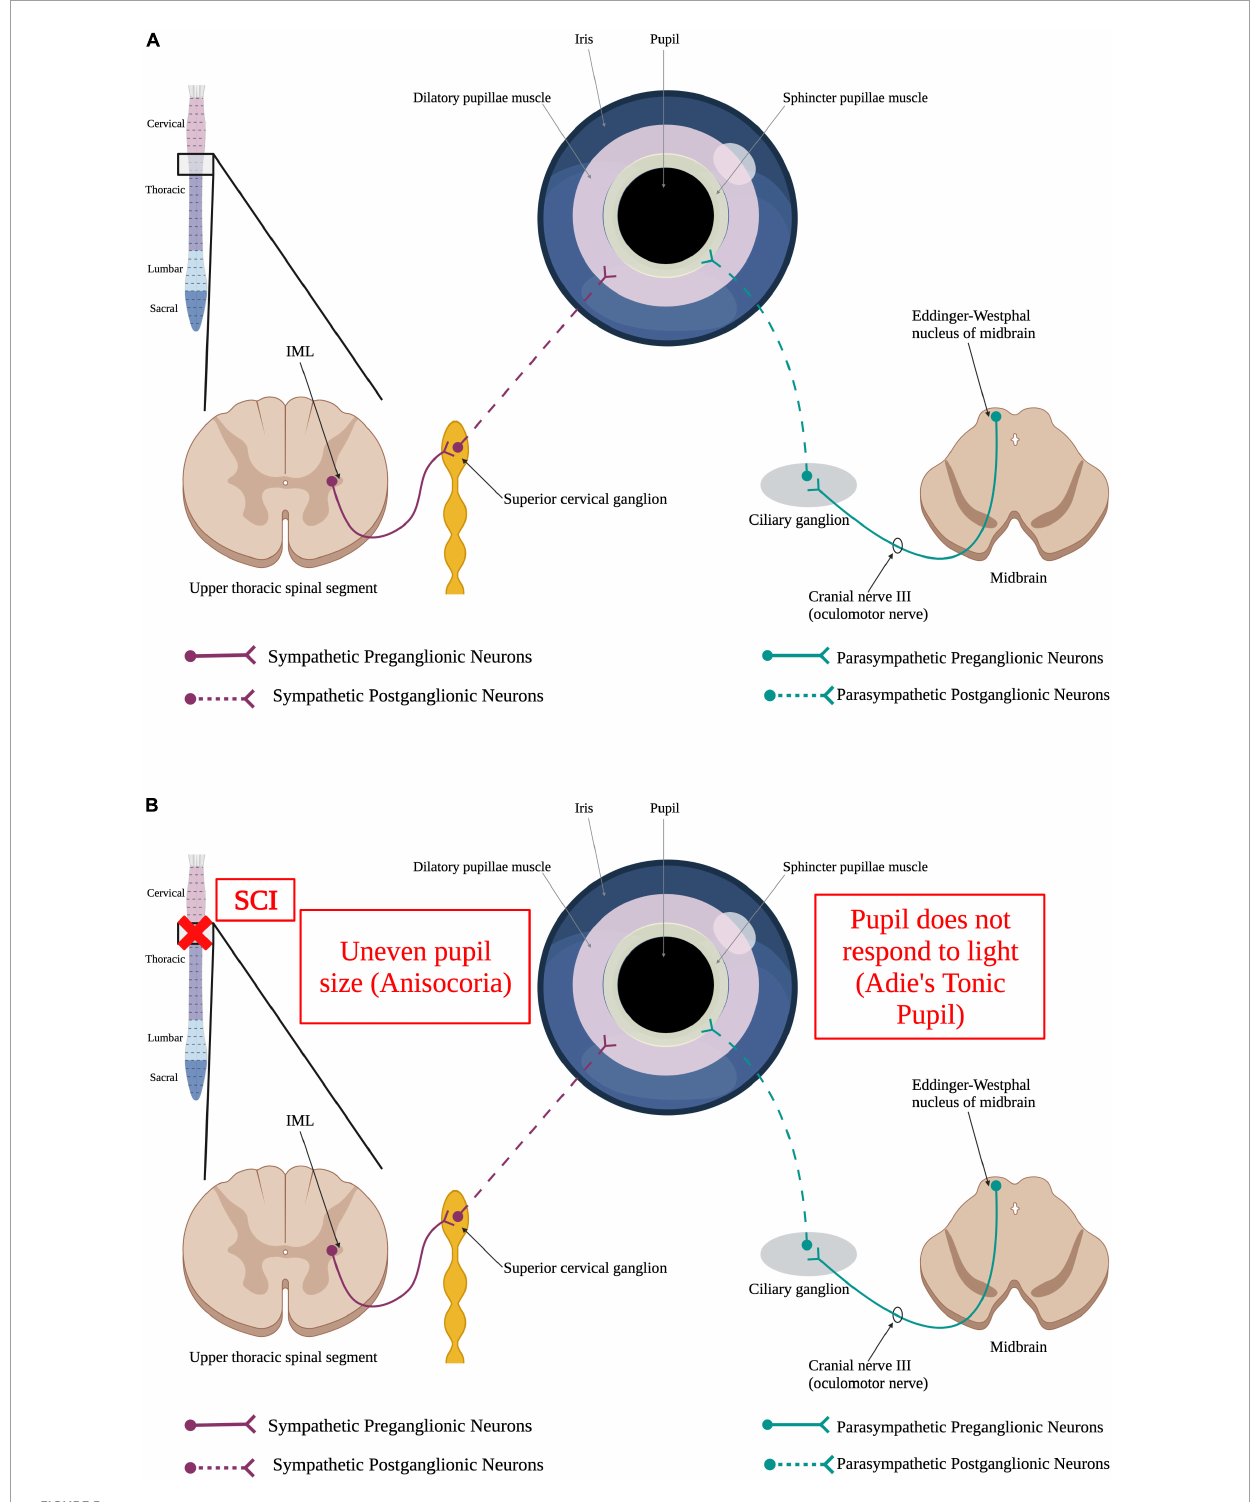
FIGURE5 Autonomic control of the pupillary light reflex and how SCI impacts it. (A) When the retina detects a dim light, it sends a stimulus to the brain via the optic nerve. This signal, in turn, results in the activation of sympathetic preganglionic neurons in the upper thoracic spinal cord that synapse onto sympathetic postganglionic neurons within the superior cervical ganglion. Some of these sympathetic postganglionic neurons innervate the dilatory pupillae muscle (pink). Release of norepinephrine from the sympathetic postganglionic neuron terminals cause the pupil to dilate to allow more light to reach the retina. Alternatively, perception of a bright light by the eye results in the activation of the parasympathetic nervous system. Parasympathetic neurons within Edinger–Westphal nucleus of the midbrain extend their axons out via the oculomotor nerve to synapse onto parasympathetic postganglionic neurons within the ciliary ganglion. These postganglionic neurons innervate the sphincter pupillae muscle (yellow) to cause the pupil to constrict, limiting the amount of light reaching the retina. (B) SCI causes irregular dilation of pupils resulting in uneven pupil size, a condition known as anisocoria, and Adie’s Tonic Pupil where the pupil does not properly respond to light. (Created using